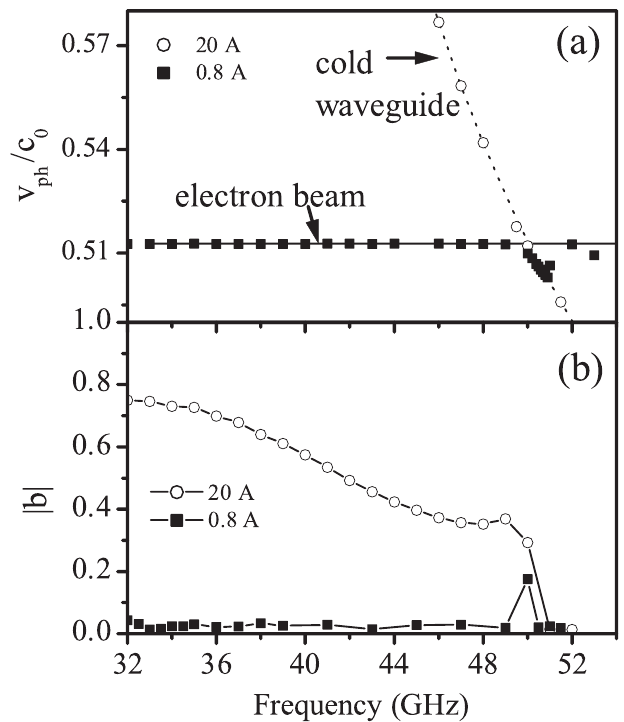
FIG. 3. Phase velocities (a) and modulus of the bunching (b) versus the frequency of the seed field for the electron-beam currents of 0.8 and 20 A, and with no fluctuations in the liner radius. Part (a) also shows the initial velocity of the electron mode in the cold beam and the phase velocity of the TM 01 waveguide. Lines are for